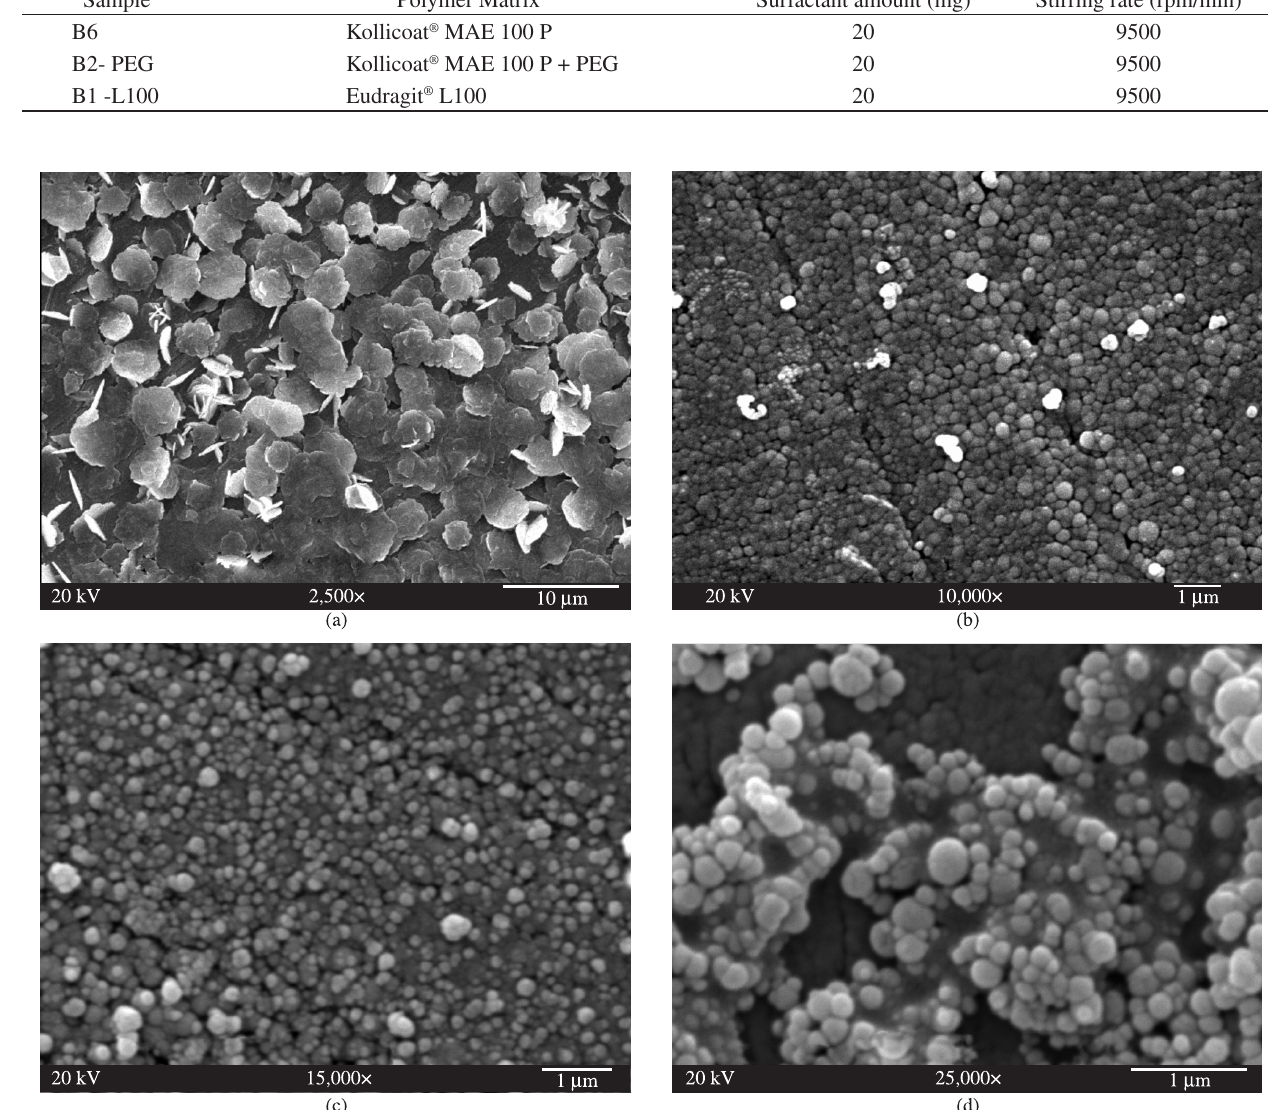
Figure 1. Scanning electron micrographs at different magnifications of sample B6: a) 2500× b) 10000× c) 15000× and